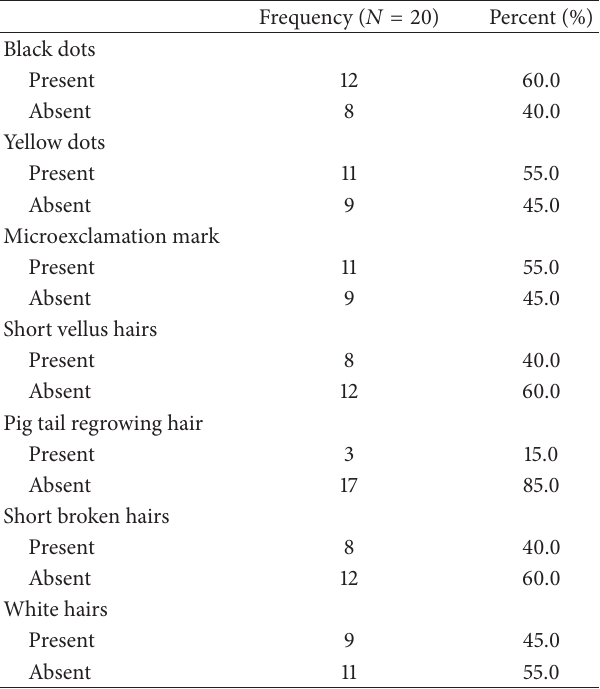
Table 2: Different trichoscopic features of alopecia